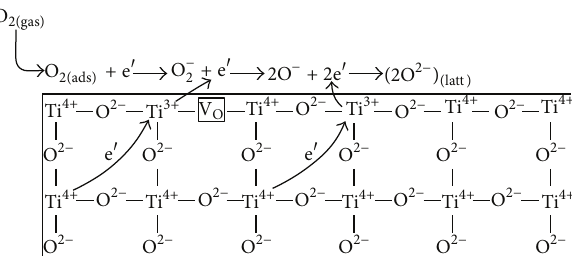
Figure 8: The Ti vacancy functions as the active site